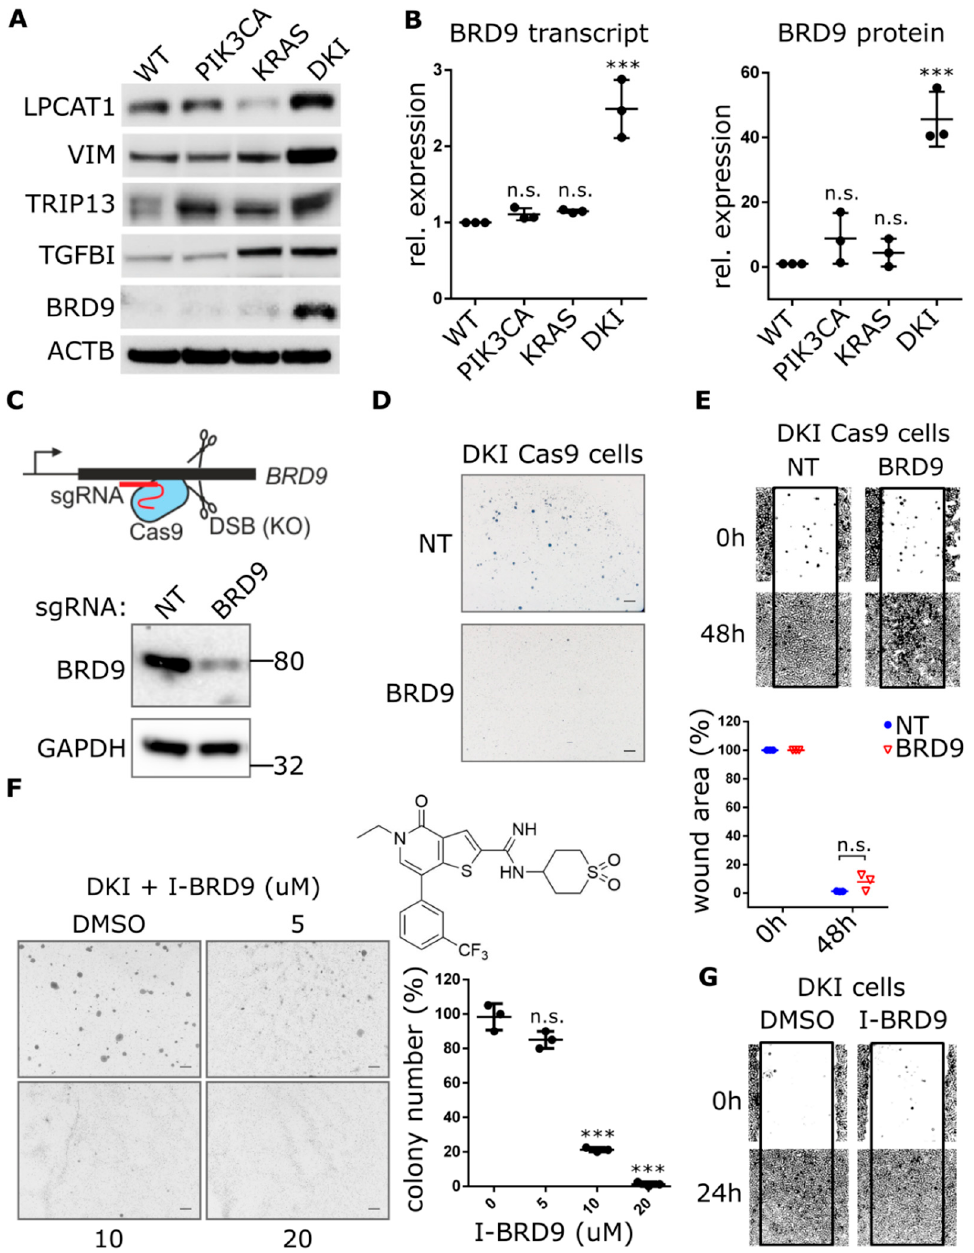
Figure 3. Genetic and pharmacological inhibition of BRD9 hampers the anchorage-independent growth but not migration of DKI cells. ( A ) Western blot analysis comparing the expression of indicated proteins in MCF10A WT and mutant cells. ( B ) Quantification of BRD9-mRNA by RT-qPCR (Mean ± SD, left panel) and BRD9 protein levels by immunoblotting (Mean ± SD, right panel) in MCF-10A WT and mutant cells. ( C ) Cartoon depicting CRISPR-Cas9-mediated gene knockout through DNA double-strand breaks and formation of insertions / deletions which disrupt the open reading frame. Lower panel: Immunoblot analysis of DKI cells transduced with CRISPR-Cas9 and sgRNA targeting BRD9. ( D , E ) Soft agar colony formation after 21 days and migration across a scratched wound over 48 h, by DKI-Cas9 cells expressing BRD9 or NT sgRNA. Lower panel: Quantitation of wound area (Mean ± SD). ( F ) Soft agar colony formation after 15 days by DKI cells in 0.3% agar supplemented with I-BRD9. Right panel: Colony number vs. dose I-BRD9 (Mean ± SD). ( G ) Migration across a scratched wound over 48 h by DKI cells treated with 20 µ M I-BRD9. ***, p < 0.001 (unpaired t -test); n.s., not significant; NT, non-targeting sgRNA; scale bars = 100 µ